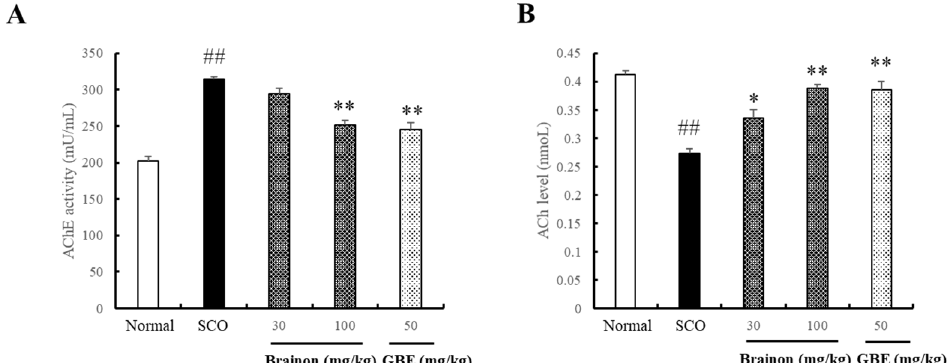
Figure 4. Effects of Brainon on acetylcholinesterase (AChE) activity and acetylcholine (ACh) level in mice hippocampal tissues. The hippocampal tissues were homogenized, and the supernatant was used for calculation of ( A ) AChE activity and ( B ) ACh level. Values were calculated in units per mg protein are represented as means ± SEM ( n = 3). ## p < 0.01 vs. Normal group; * p < 0.05 and ** p < 0.01 vs. SCO-treated group.